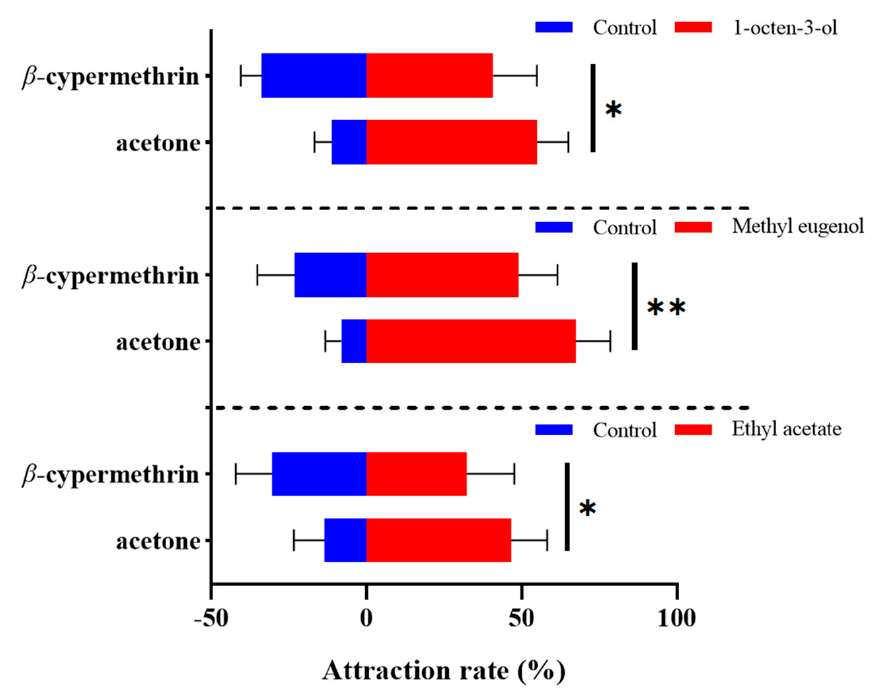
Figure 1. Four-way olfactometer assay of 7-day-old adults treated by β -cypermethrin (LD 30 = 10 ng/fly). We used 1-octen-3-ol, methyl eugenol and ethyl acetate at 1% ( v / v ) concentration as the attractants. Females, males and both sexes were employed in the assays of 1-octen-3-ol, methyl eugenol and ethyl acetate, respectively. Data were presented as mean ± SE ( n = 6). Asterisks represent a significant difference determined by Student’s t -test (* p < 0.05; ** p <